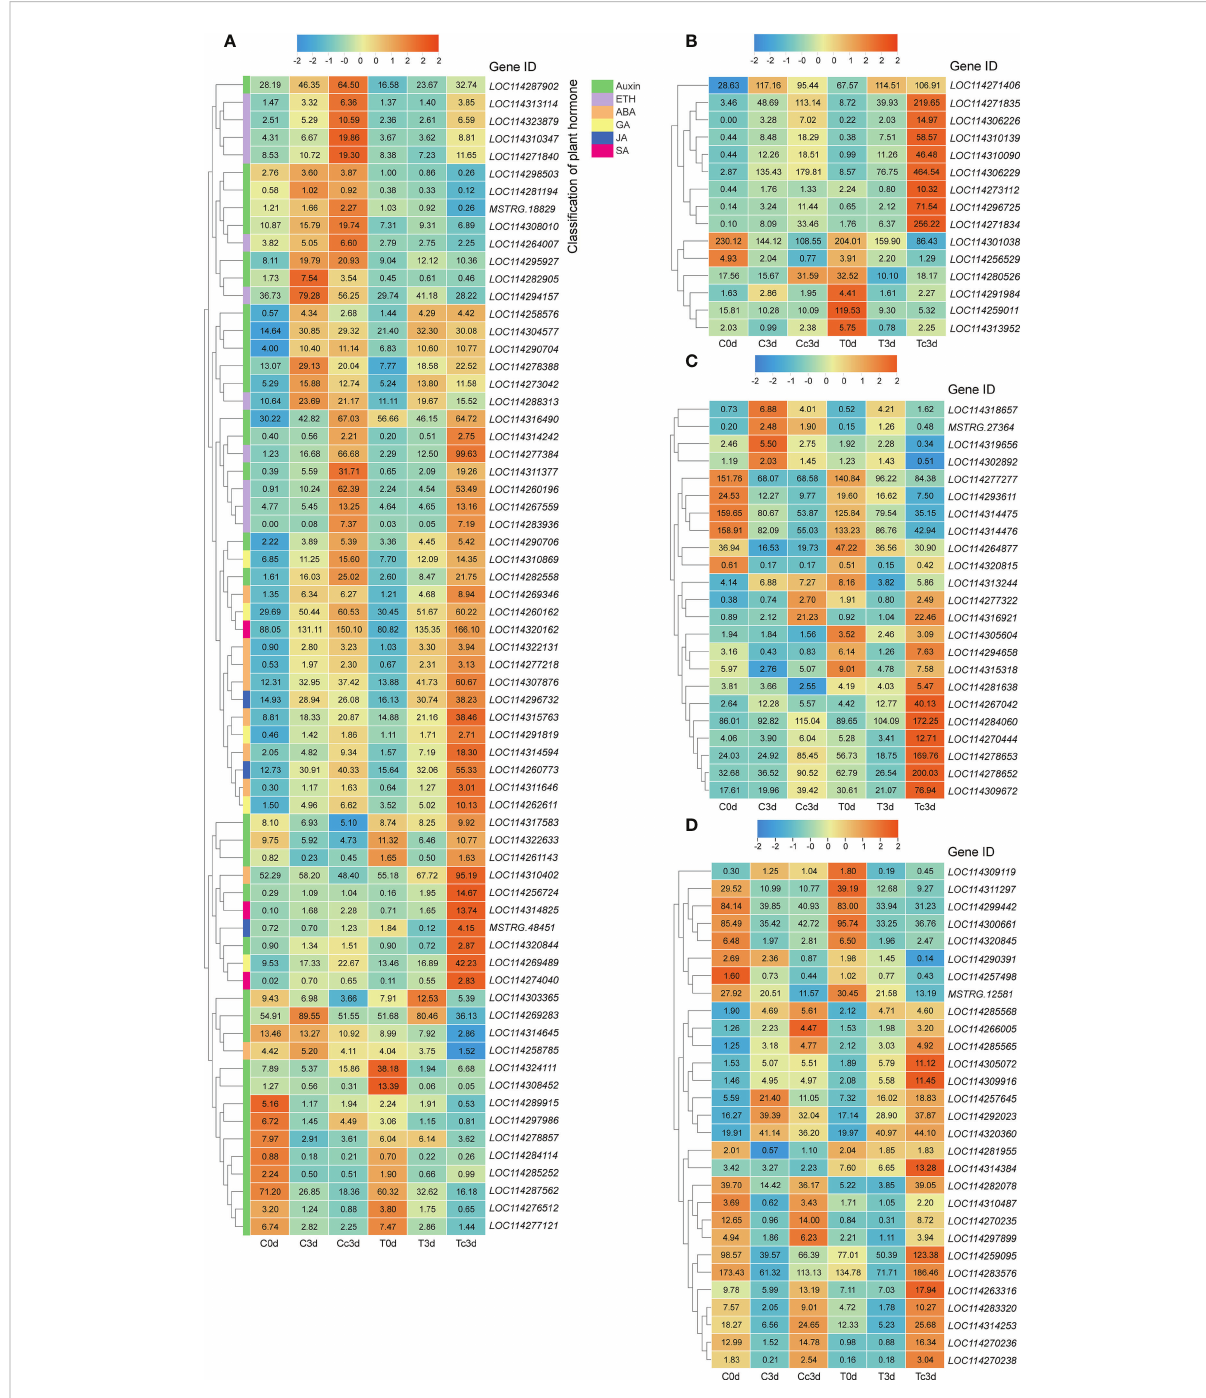
FIGURE 1 Different categories of differentially expressed genes (DEGs). (A) DEGs related to plant hormone. (B) DEGs related to pathogenesis-related proteins. (C) DEGs related to the antioxidant system. (D) DEGs related to fl avonoid metabolism. ETH: ethylene; ABA: abscisic acid; GA: gibberellin; JA: jasmonic acid; SA: salicylic acid. “ C, ” “ d, ” “ T, ” and “ c ” indicated “ non-mycorrhizal, ” “ days post infection, ” “ mycorrhizal, ” and “ Colletotrichum camelliae , ” respectively. The annotation of DEGs is listed in Supplementary Material